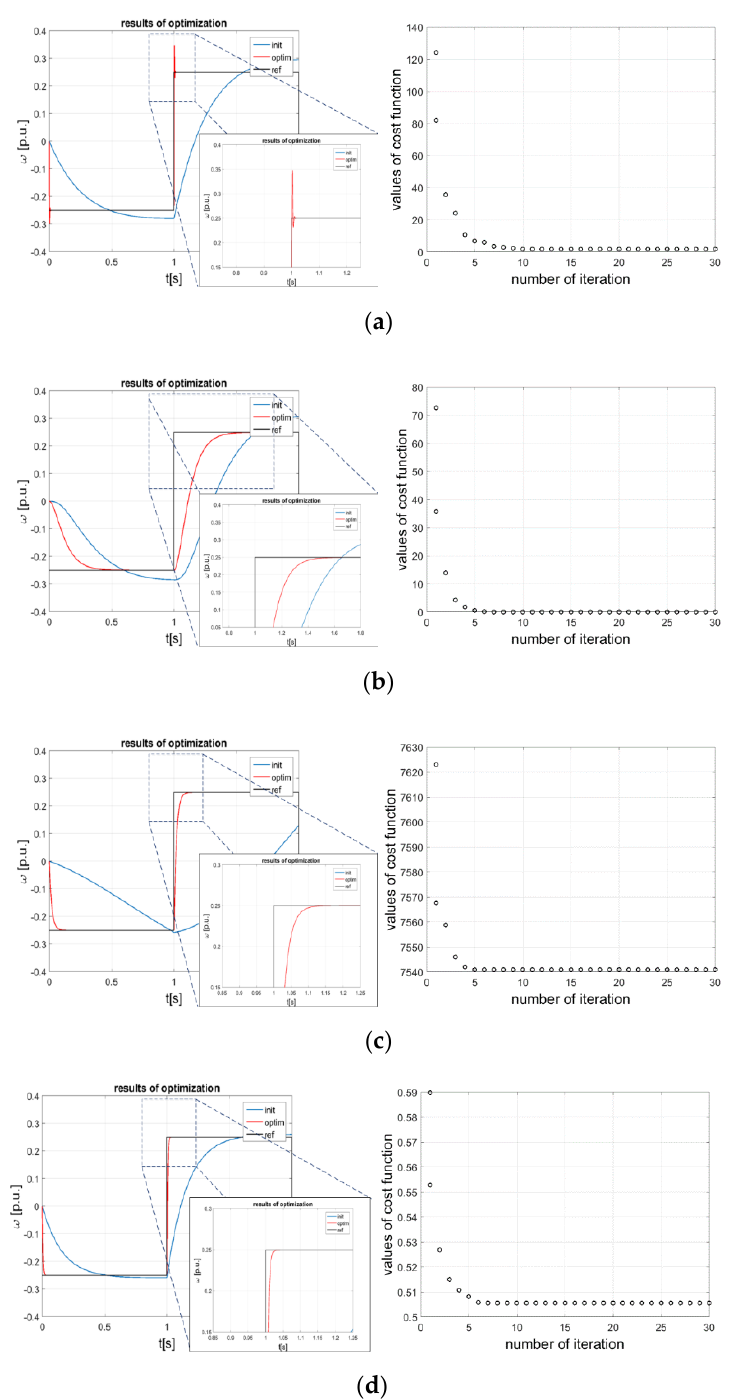
Figure 4. Results of optimization—speed signals and cost function—performed for different conditions: using Equation (45) as a cost function ( a ), with input filter ( b ), with noise in speed signal ( c ), and with formula (60) applied as objective function definition ( d ).